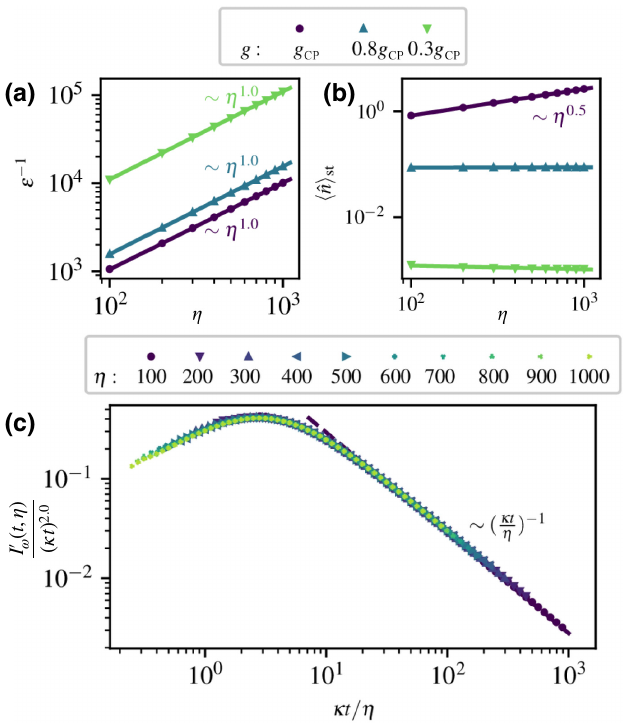
FIG. 9. Numerical finite-size scaling of (a) the inverse of the Liouvillian gap ε − 1 and (b) the steady mean cavity occupation η and for different values of g . (c) (cid:6)ˆ n (cid:5) st for different system sizes Scaling of the global QFI I (cid:12) ω ( t , η) when g is tuned away from the CP, g = 0.8 g CP . Parameters: ω = 1 and κ =